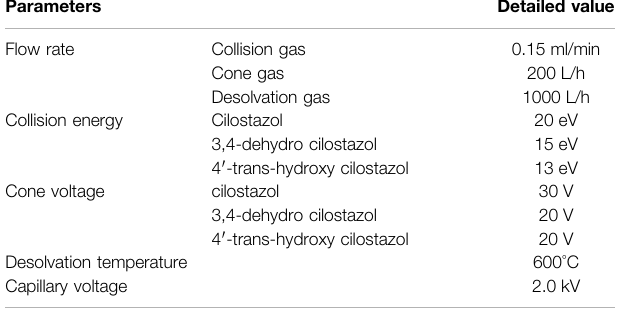
TABLE 2 | Parameters of mass